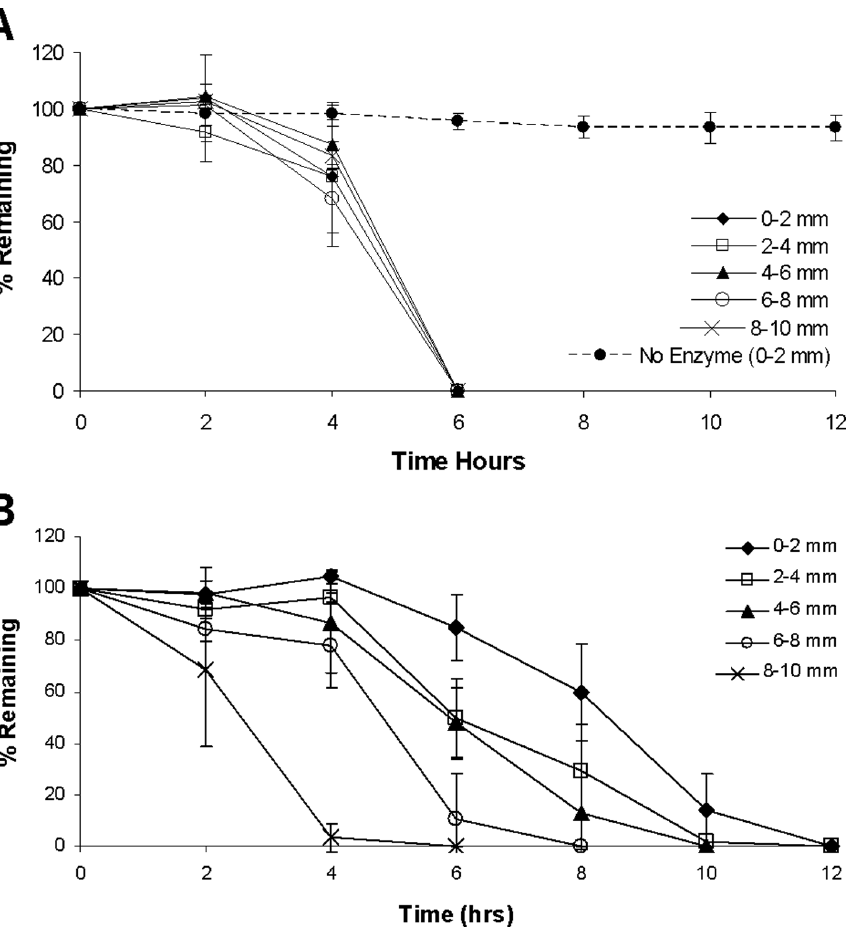
Figure 4. Quantification of hydrogel degradation kinetics. Degradation kinetics of hydrogel sections taken from different regions of (A) bulk polymerized control gels and (B) PBFP gradient hydrogels when exposed to 1 m g/mL collagenase-1A (MMP-1) (n=3). Error bars represent 6 standard deviation.